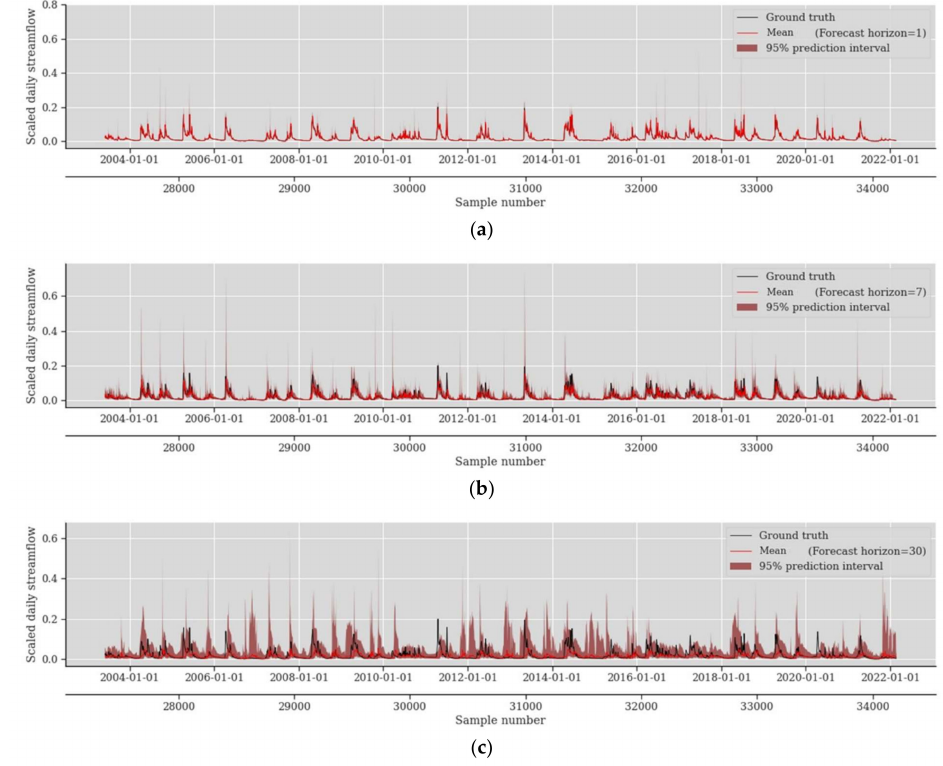
Figure 8. Probabilistic streamflow forecasting results obtained by LSTM-BNN for case study II